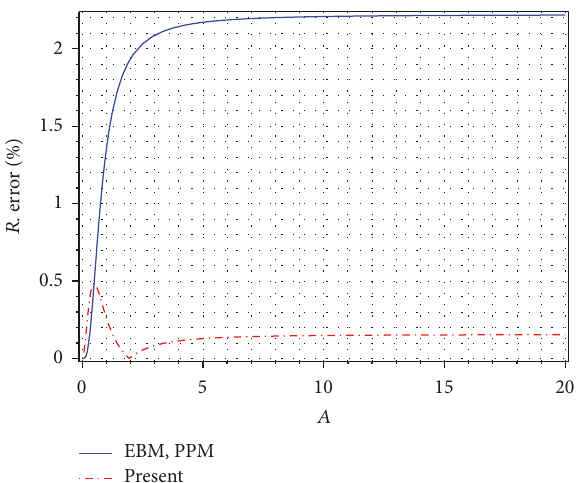
Figure 3: Comparison of relative error between the present and PPM solutions with 𝛼 = 2 and 𝛽 = 5 , Example